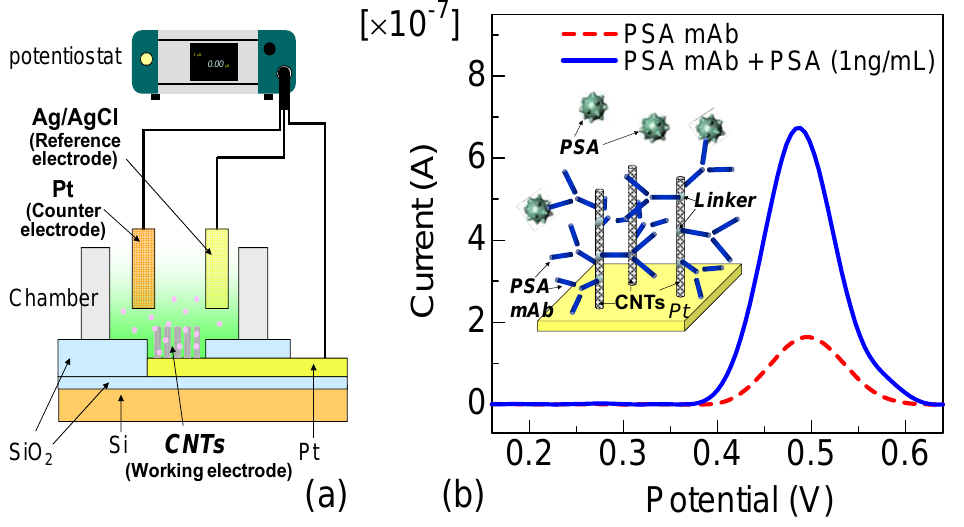
Figure 2. (a) Schematic illustration of experimental setup for the label-free amperometric biosensor. (b) Electrochemical signals obtained from CNT electrodes recorded using DPV. The dotted and solid lines correspond to the electrochemical signals from PSA-mAb and after introduction of 1 ng/mL PSA, respectivity. PSA-mAb was covalently immobilized on the CNTs using